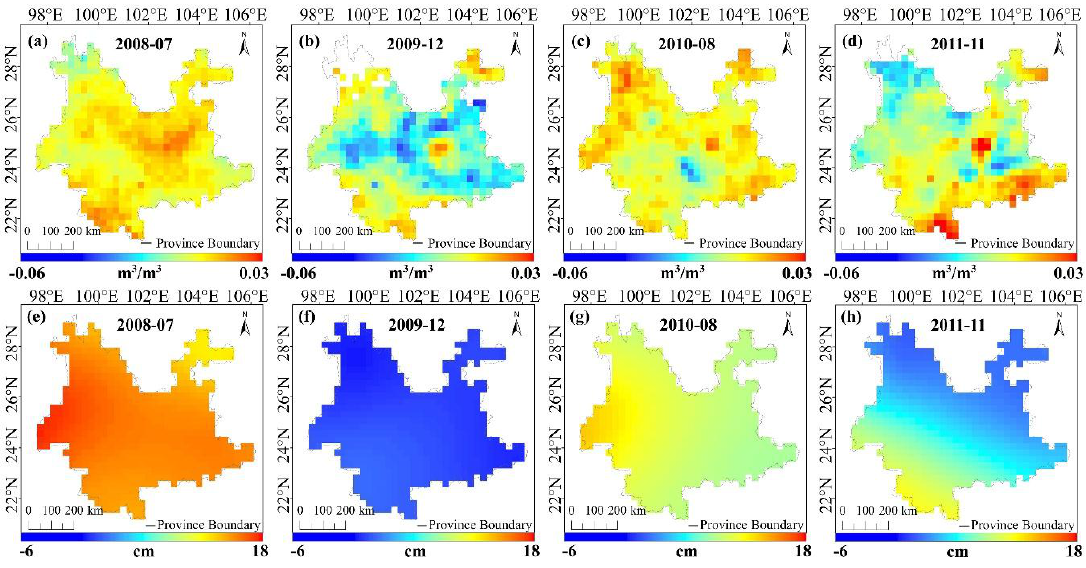
Figure 7. Spatial distribution of CCI Soil Moisture Anomalies ( a – d ) and Total Water Storage Anomalies ( e – h ) in July 2008 (end of the “big wet”), December 2009 (end of the “second big dry”), August 2010, and November 2011.